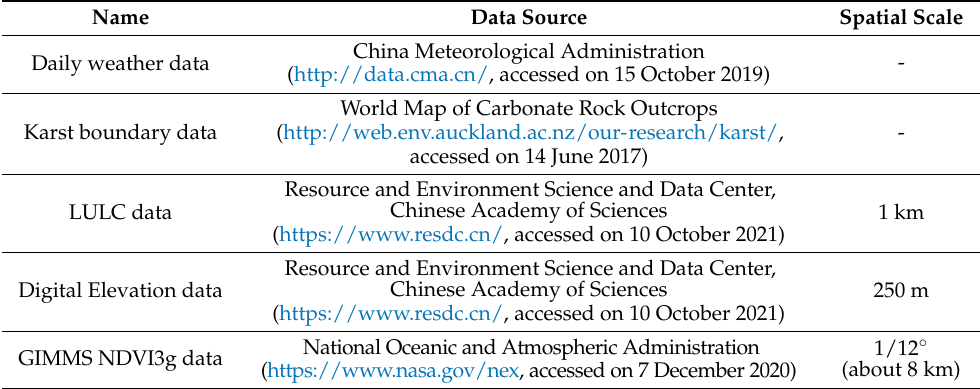
Table 1. Datasets used in this